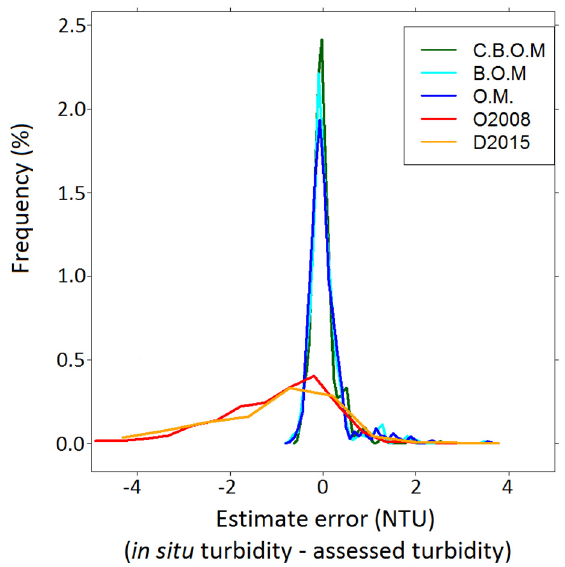
Figure 4. Error density distribution on the 10 test samples obtained with the different SVR models (i.e., C.B.O.M., B.O.M., and O.M.) and with the O2008 and D2015 models.